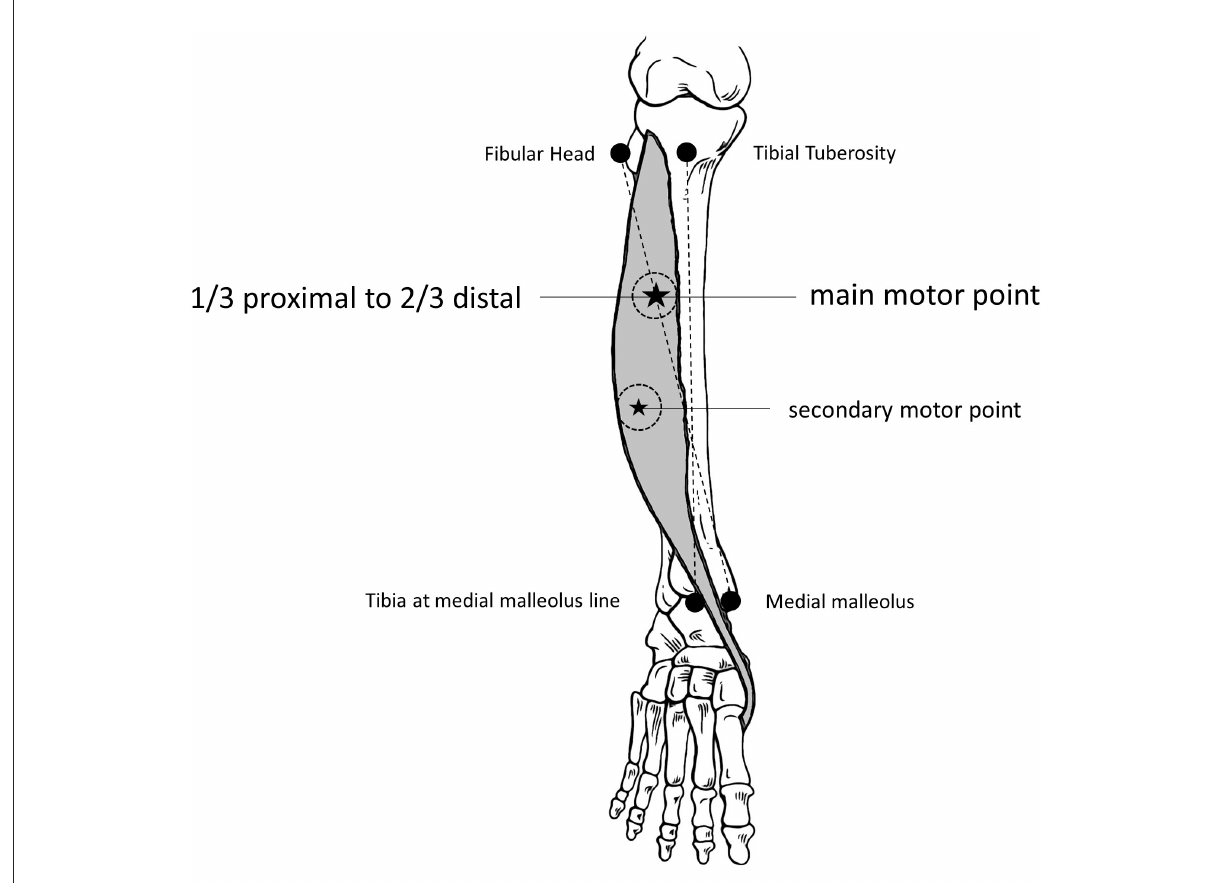
FIGURE1 Tibialis Anterior muscle anatomical markers for the motor endplate (motor point). See the main and the secondary motor points, where the monopolar stimulation needle should be inserted, and the 2 to 3cm around, where the concentric needle will be inserted (twitching muscle).